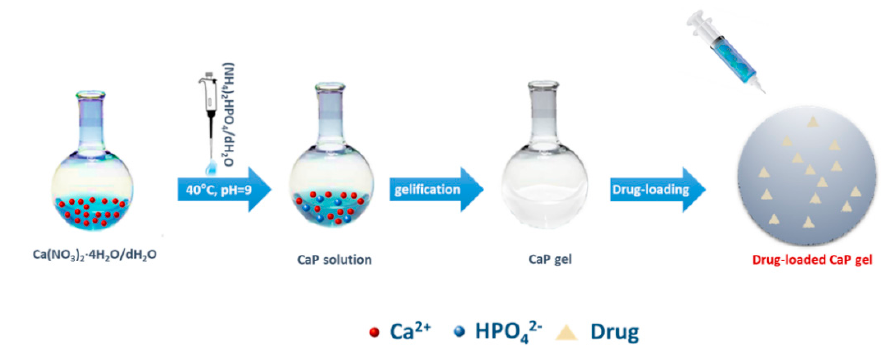
Figure 1. Scheme representing the preparation of drug-loaded calcium phosphate-based (CaP) injectable materials. The drug represents alendronate or diclofenac or harpagoside.